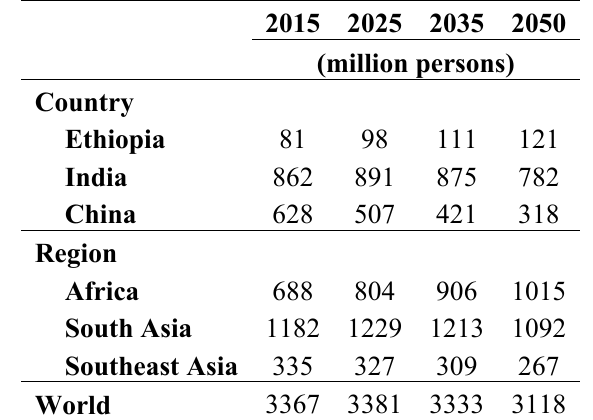
Table 1. Rural population projections for selected countries and regions, 2015 to